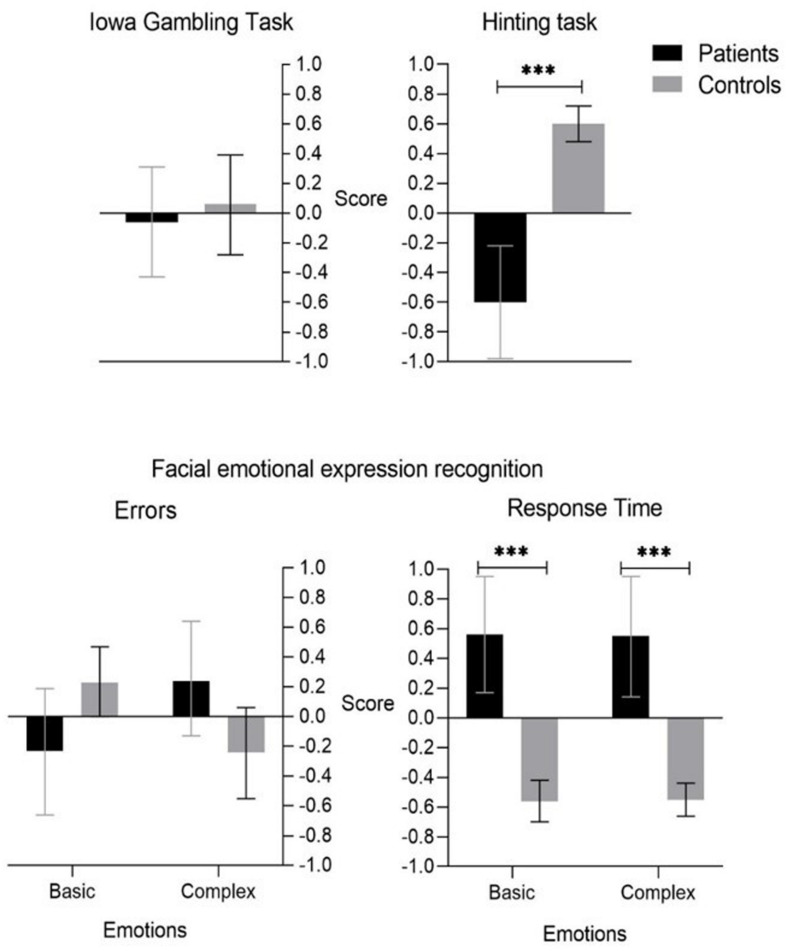
Hot Executive Functions tasks. **p < 0.01, ***p < 0.001.